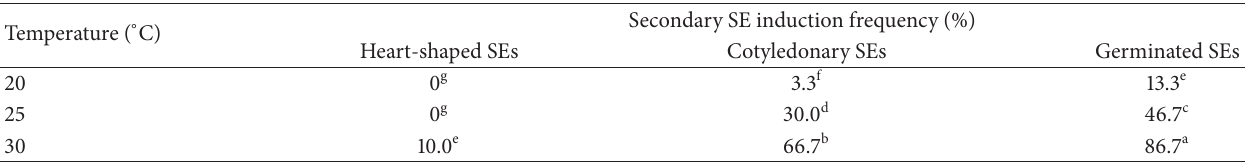
Table 1: Effects of temperature and developmental stage of SEs on induction of secondary SEs in H. dulcis after 6-week culture on MS agar medium without plant growth regulators X .